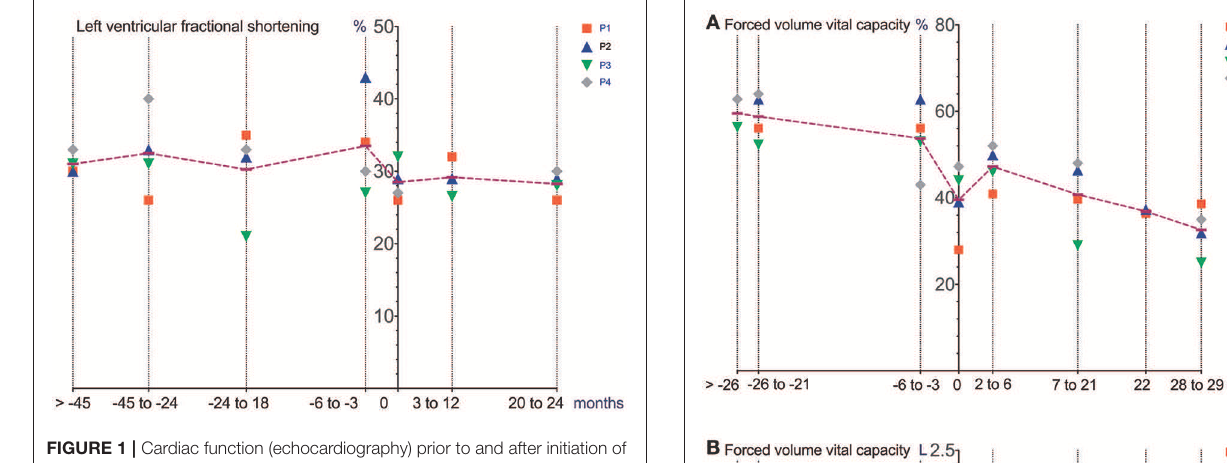
FIGURE 1 | Cardiac function (echocardiography) prior to and after initiation of Ataluren treatment. Graphic representation of LVFS [%] in relation to time. Time point 0 represents start of Ataluren treatment in all figures (P1 and P2 13th October 2015; P3 and P4 5th February 2016). Age at start of Ataluren: P1 and P2 14 10/12 years; P3 14 9/12 years; P4 11 11/12 years). Note that time period’s alternate because of a lack of data in some values. LVFS, left ventricular fractional shorting.